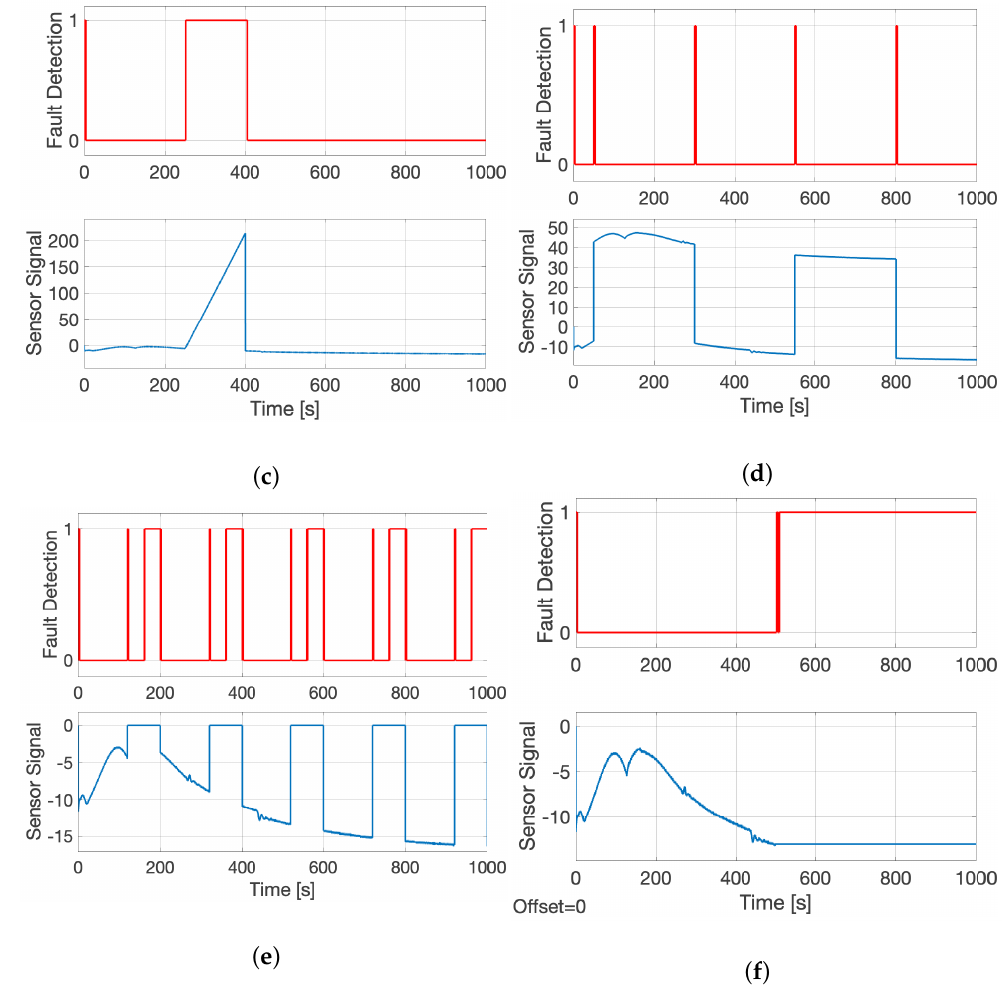
Figure 3. Sensor faults and failure detection examples. ( a ) Spike fault; ( b ) Erratic fault; ( c ) Drift Fault; ( d ) Hardover Fault; ( e ) Data Loss Fault; ( f ) Stuck